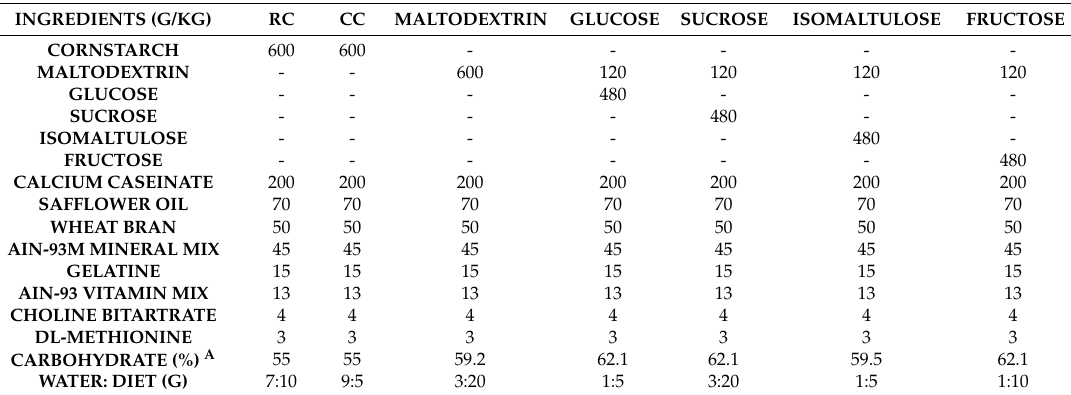
Table 1. Diet components, based on a modified AIN-93 diet [20]. AIN—American Institute of Nutrition; RC—raw cornstarch; CC—cooked